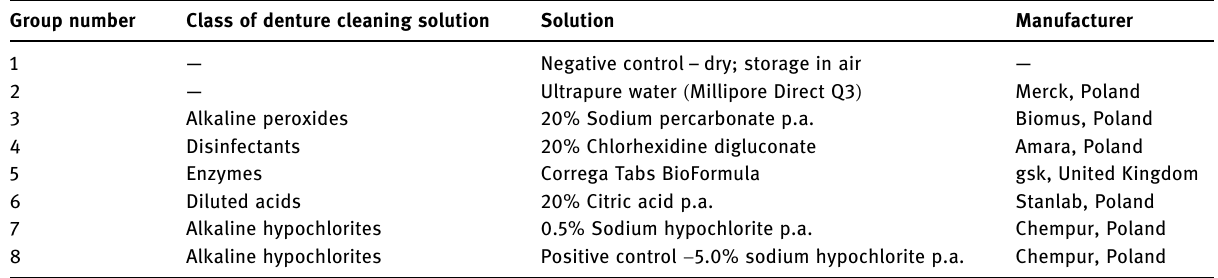
Table 1: Description of the solution for Co – Cr immersion Group